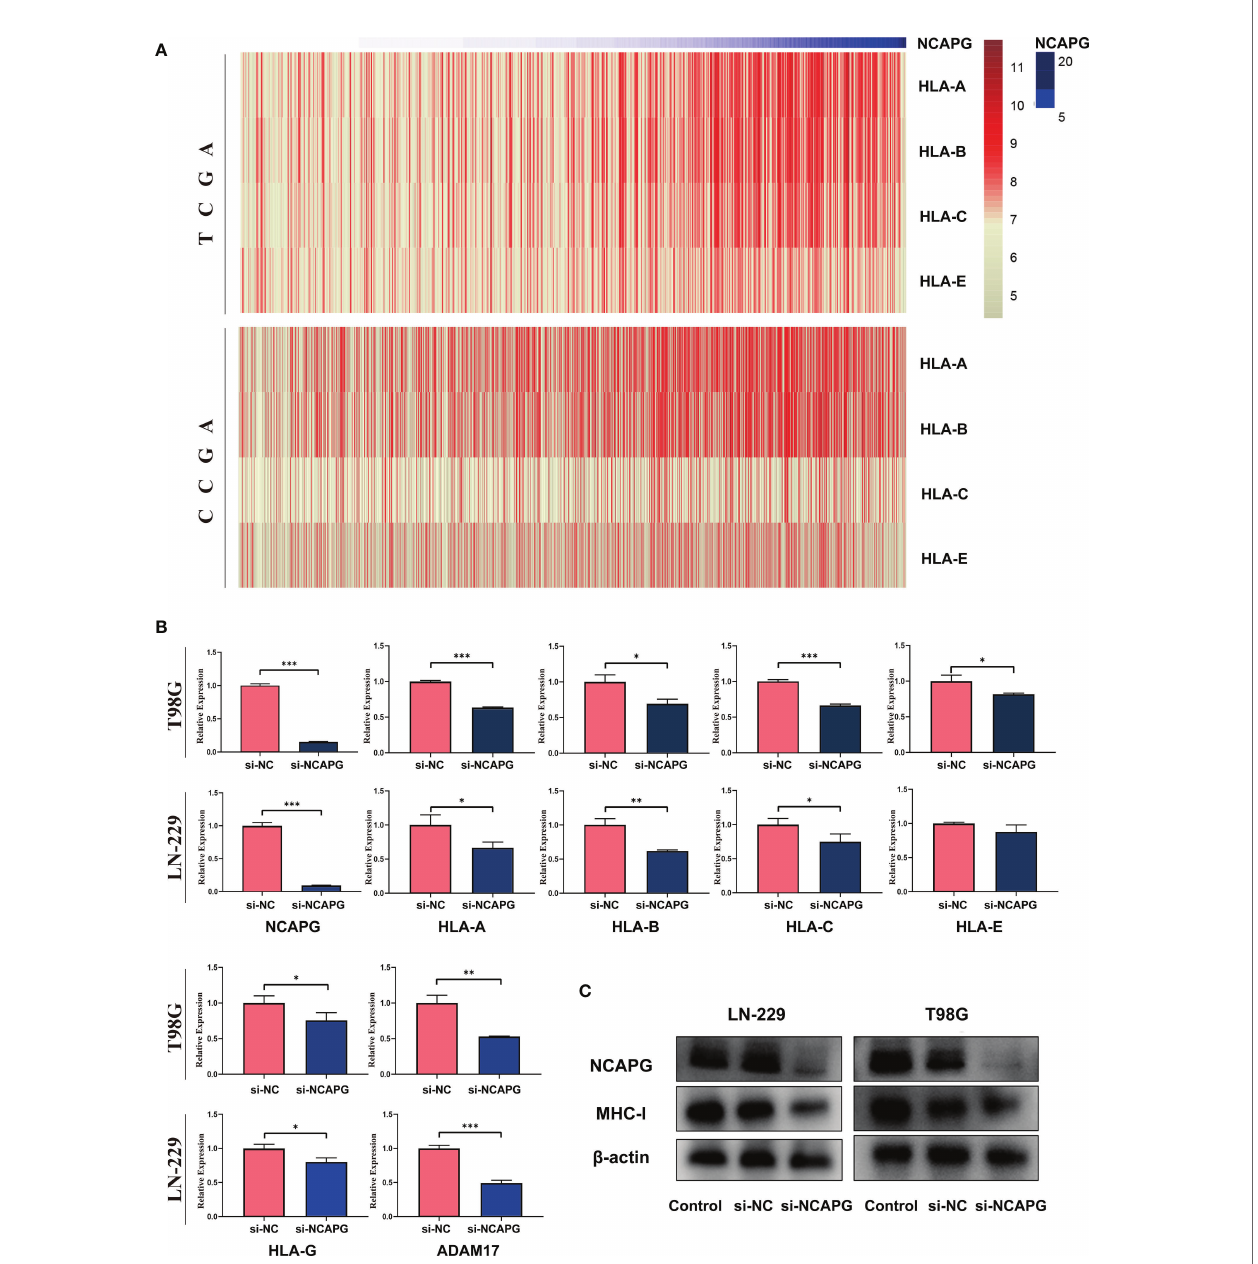
FIGURE 7 | NCAPG affects the expression of major histocompatibility complex-I (MHC-I) in glioma. (A) Heatmap of the relationship between NCAPG expression and MHC-I in the TCGA and CGGA datasets. (B) The expression of NCAPG in relation to different MHC-I molecules and ADAM17 with RT-qPCR assay. (C) The relationship between NCAPG and MHC-I molecule expression using western blot analysis. (*P < 0.05, **P < 0.01, ***P <